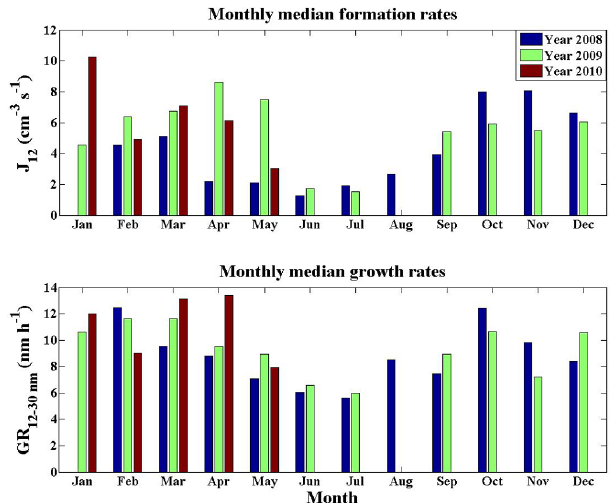
Fig. 10. Monthly median formation rates of 12–30nm parti- cles ( J 12 ) and growth rates (GR 12 − 30nm ) based on the DMPS data. The figure includes observations made during February– December 2008, January–July 2009, September–December 2009, and January–May 2010.